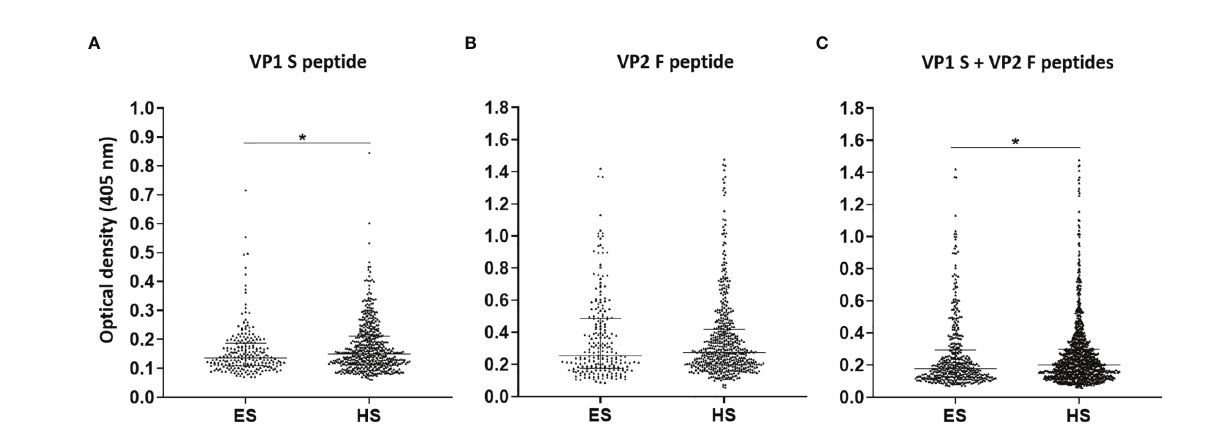
FIGURE 3 | Serologic pro fi les of serum antibody reactivity to Merkel cell polyomavirus (MCPyV) VP1 S (A) and VP2 F (B) peptides and for combined S and F peptides (C) evaluated in elderly subjects (ES) compared with healthy subjects (HS). Immunologic data are from ES (n = 226) and HS (n = 548), and results are reported as optical density (OD) value readings at l 405nm for sera analyzed in indirect ELISA. In the scatter dot plot, each dot represents the dispersion of ODs for each sample. The median is indicated by the line inside the scatter plot with the interquartile range (IQR) in ES and HS cohorts. (A) *p < 0.05; (C) *p <